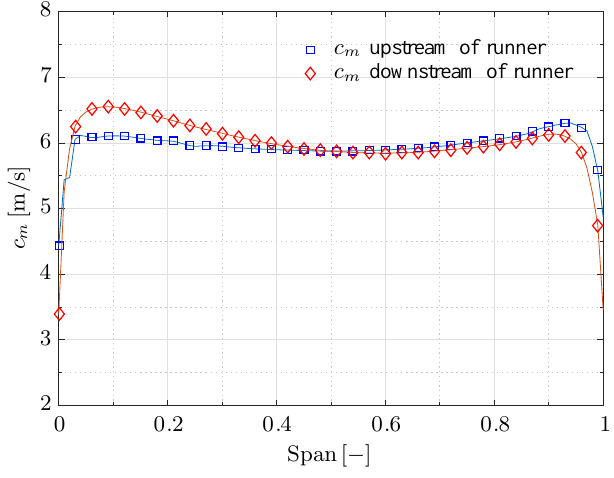
Fig. 7. Efficiency at guide vane angles γ from +7.5 ◦ to -10 ◦